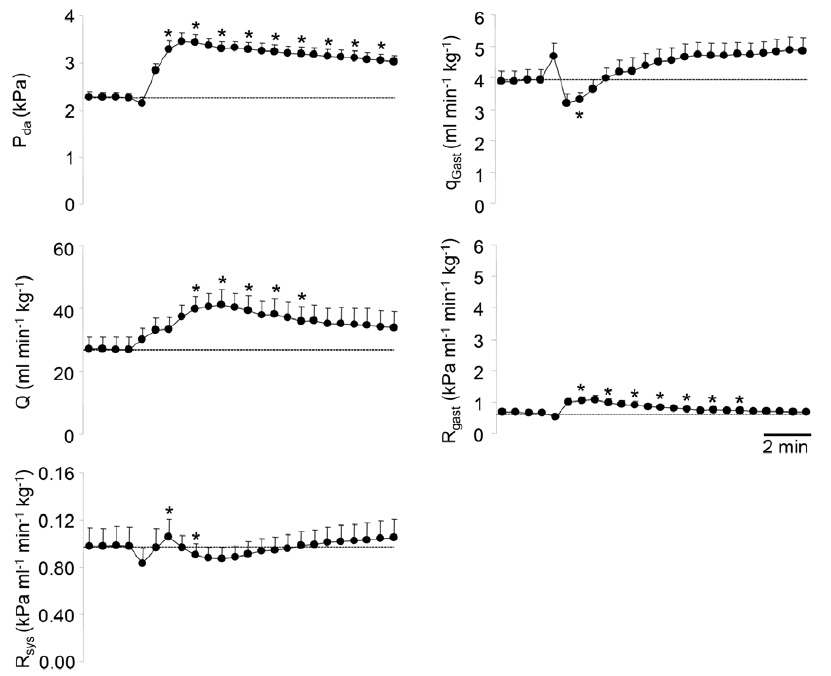
Figure 5. Cardiovascular responses to angiotensin II. Angiotensin II (5 nmol kg 2 1 ) was injected into unfed P. borchgrevinki (N=7–12). The variables are dorsal aortic blood pressure (P da ), cardiac output (Q), systemic vascular resistance (R sys ), gastrointestinal blood flow ( q gast ) and gastrointestinal vascular resistance (R gast ). Dotted vertical lines extrapolate baseline values for visual aid. Values are means ( + S.E.M.) and * denotes significantly different value (p , 0.05) from the pre-injection control period.